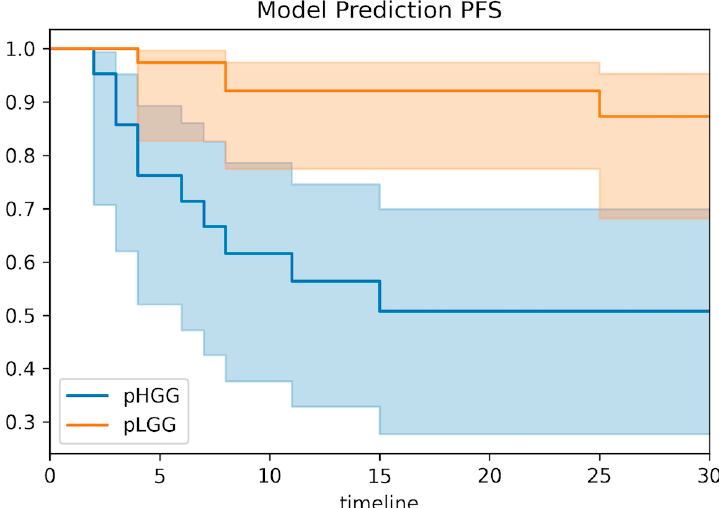
Figures 6. Model correlations with patient progression-free survival. Based on the combined pre- dictive model, patients were classified as pHGG or pLGG based on the probability threshold of 17.3%. Kaplan–Meier estimates of model predictions presented significant correlations with patient progression-free survival (PFS) ( p < 0.001).